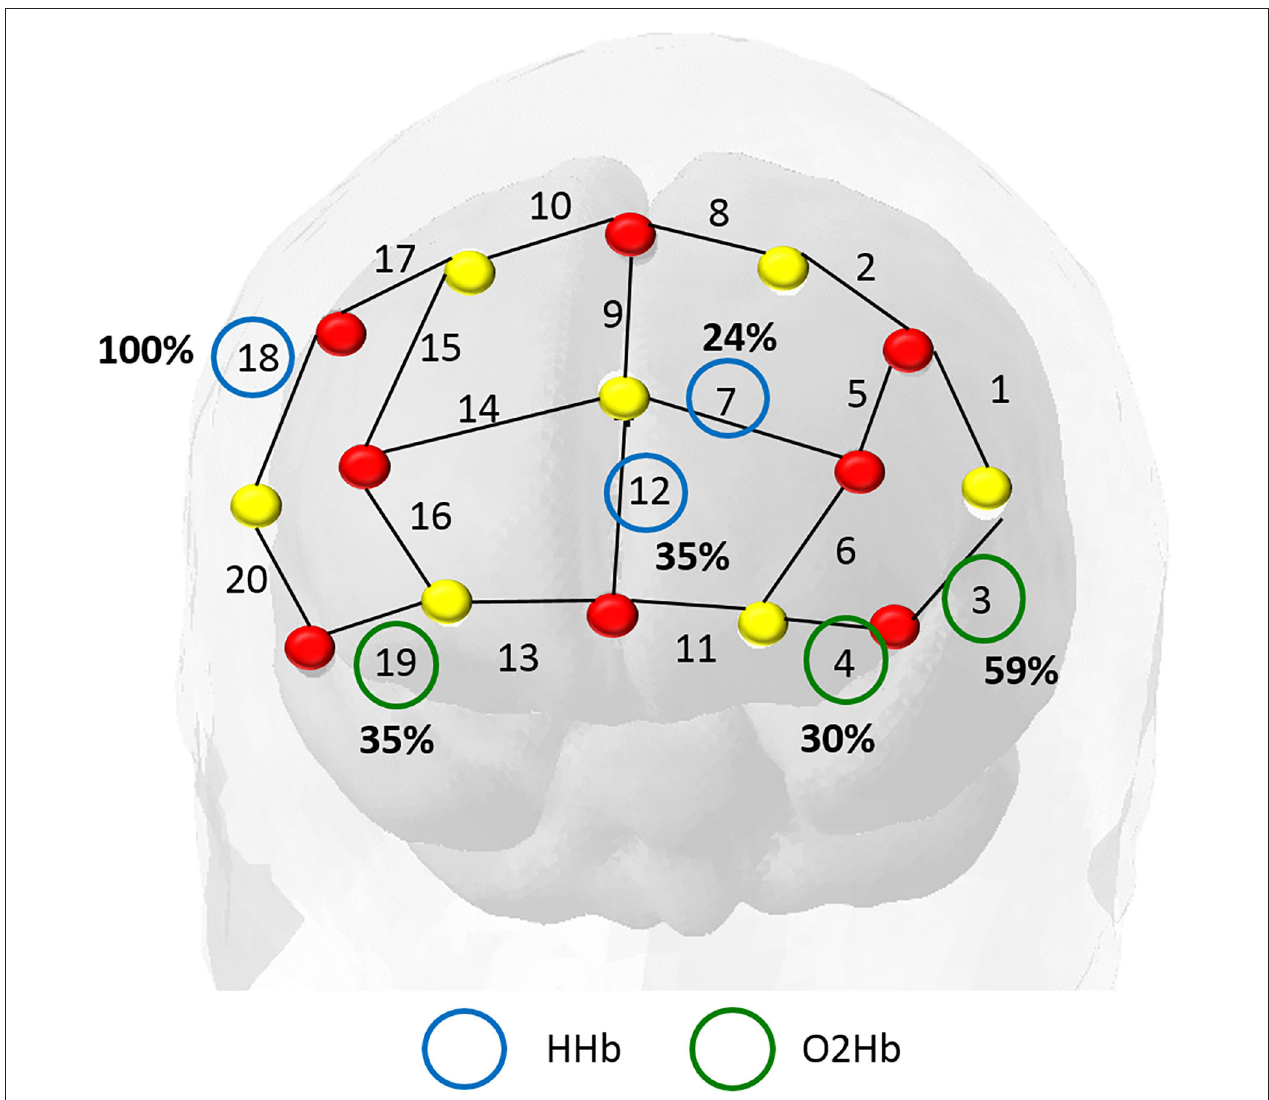
FIGURE 5 | In this map, the red dots represent the sources and the yellow dots the detectors. We identified the most important channels from the total iterations in training the model. The frequency of the main covariables identified were: deoxyhemoglobin (blue circles) in channel 18 (highly relevant in all subjects) and oxyhemoglobin (green circles) in channel 3 (present in 60% of the subjects).